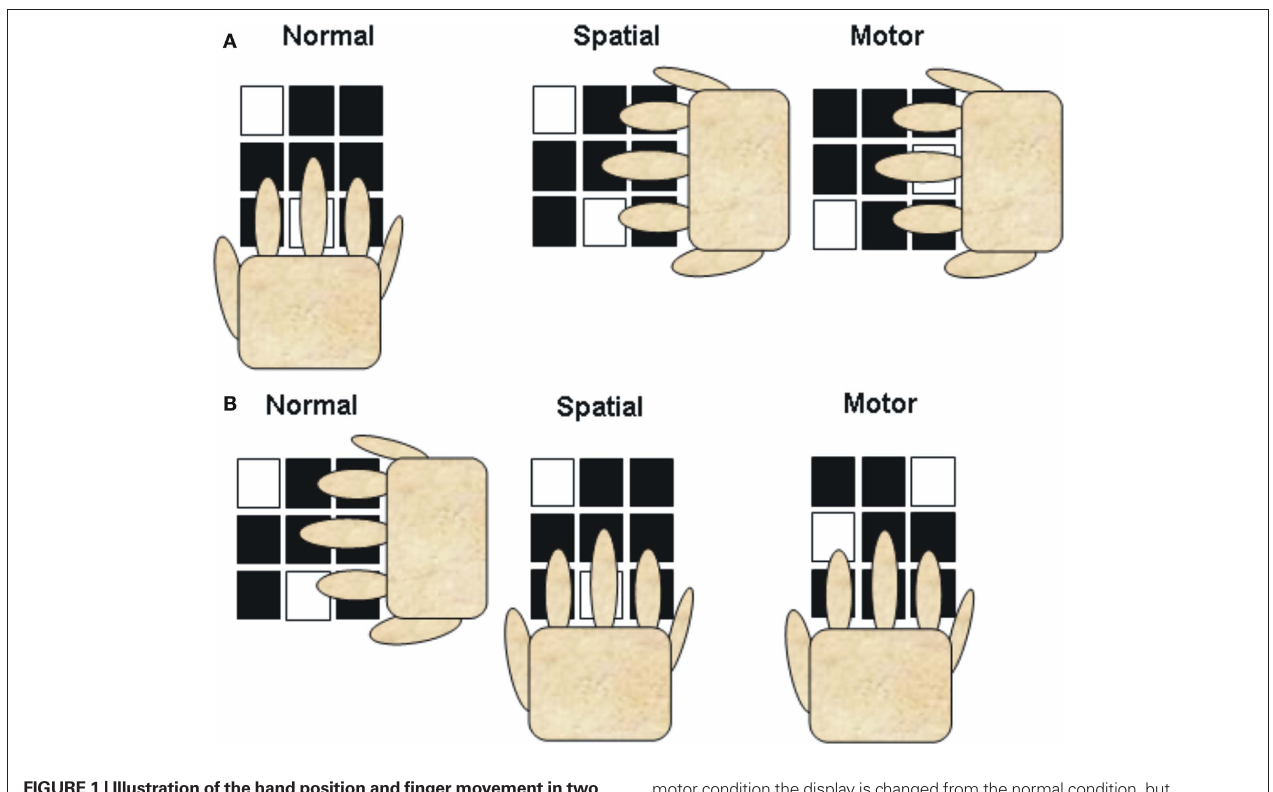
motor condition the display is changed from the normal condition, but because the hand position has changed the same fingers and movements are required. Note that the illustration only depicts a single set. In the 2 × 10 tasks, a trial was composed of 10 sets. (redrawn from Bapi et